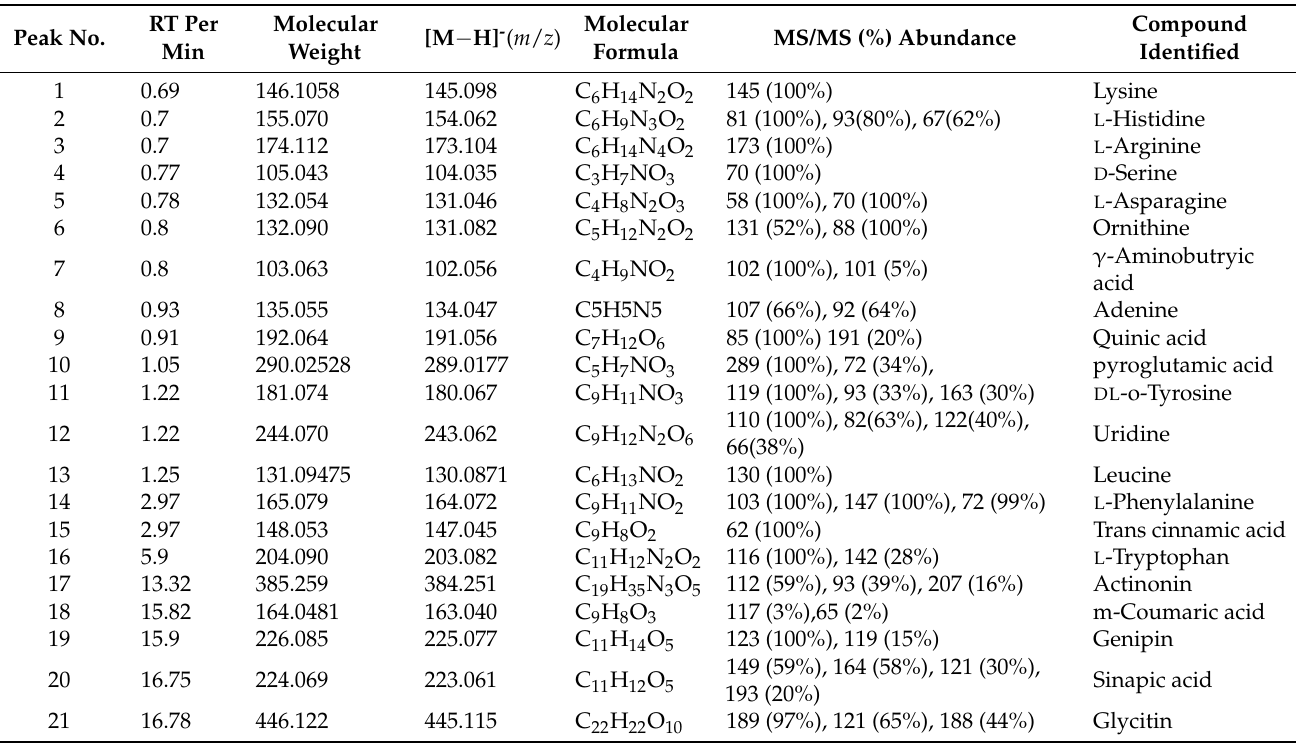
Table 5. Metabolites identified in the ethanol extracts of red cabbage sprouts using UHPLC-Q-TOF-MS2. RT, retention time. Peak No.